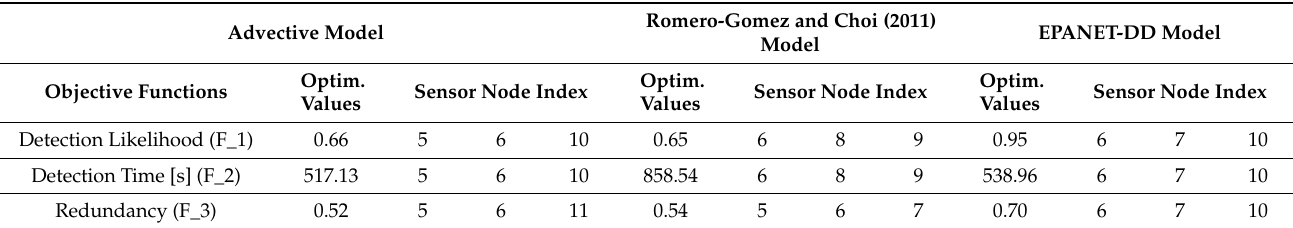
Figure 4. Optimal sensor positioning for the UKE Laboratory Network. Table 1. Numerical analysis: Results of the Optimisation